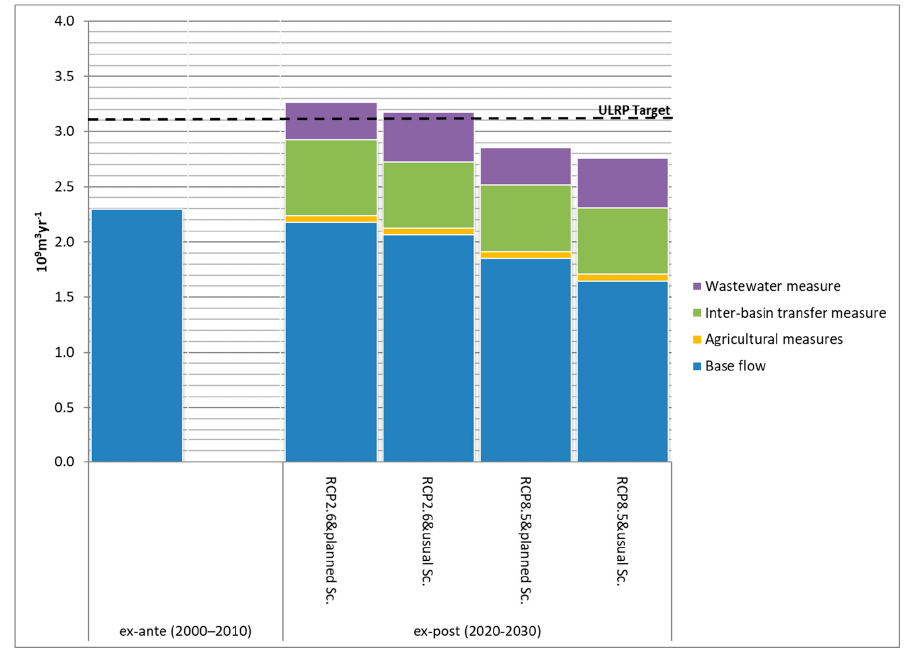
Figure 5. The ex-ante (2000–2010) and ex-post (2020–2030) outflows to the Urmia Lake under two different climate change scenarios (RCP2.6 and RCP8.5) and two different socioeconomic scenarios (business-as-planned and business-as-usual). The dashed line is the Urmia Lake Environmental Flow Requirements (EFRs) estimated by Abbaspour and Nazaridoust [64], which is the Urmia Lake Restoration Program’s (ULRP’s)